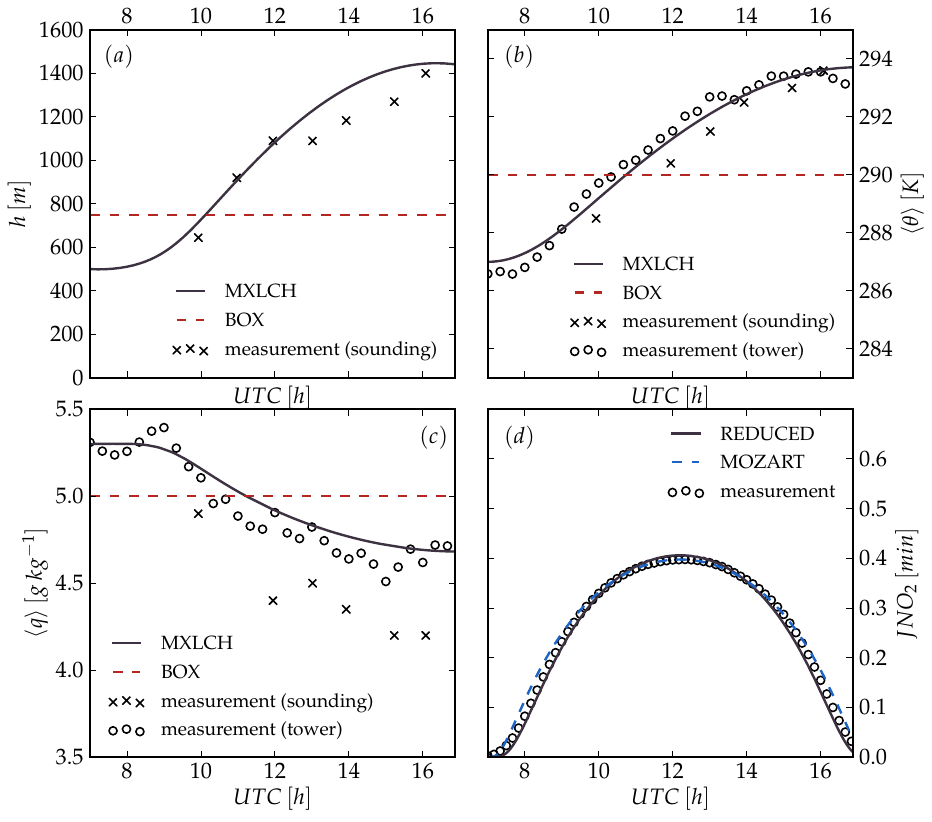
Fig. 3. Time evolution of the (a) mixed-layer height, (b) slab averaged potential temperature, (c) slab averaged specific humidity and (d) pho- tolysis rate of NO 2 , compared to the measurements. In addition to the results of MXLCH, the fixed conditions of the box model are